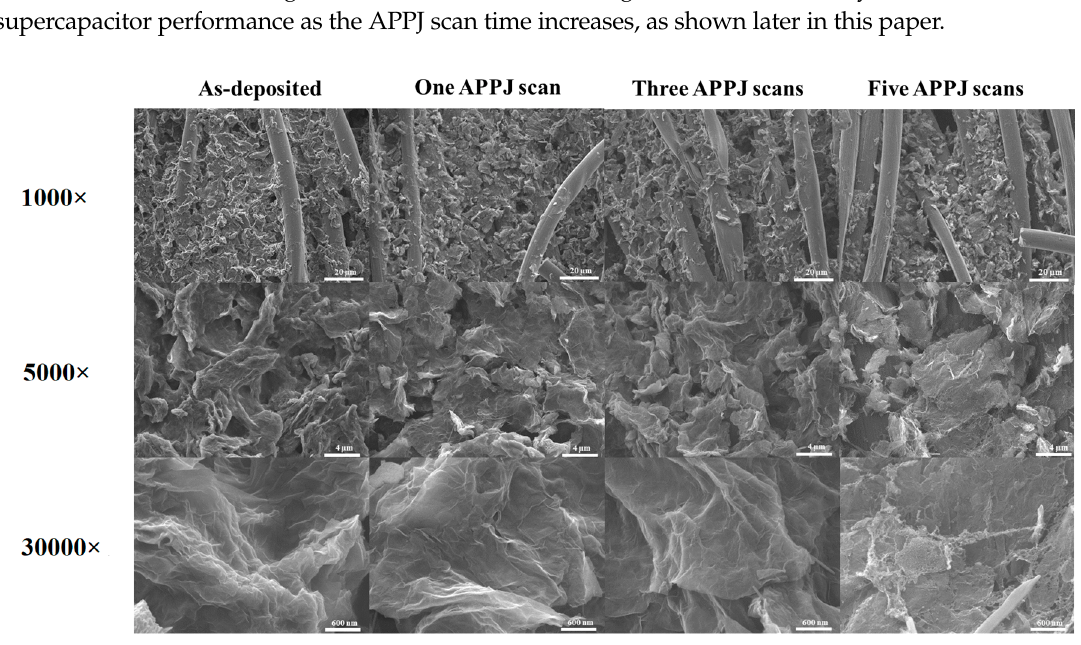
Figure 3. SEM images of the APPJ-processed rGOs on carbon cloth.